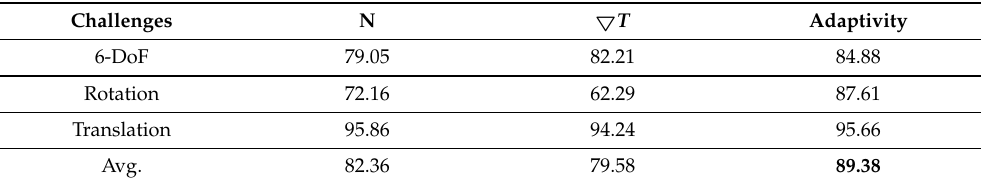
Table 7. Using the Precision Plot metric for comparison in an ablation study, and the best results are highlighted